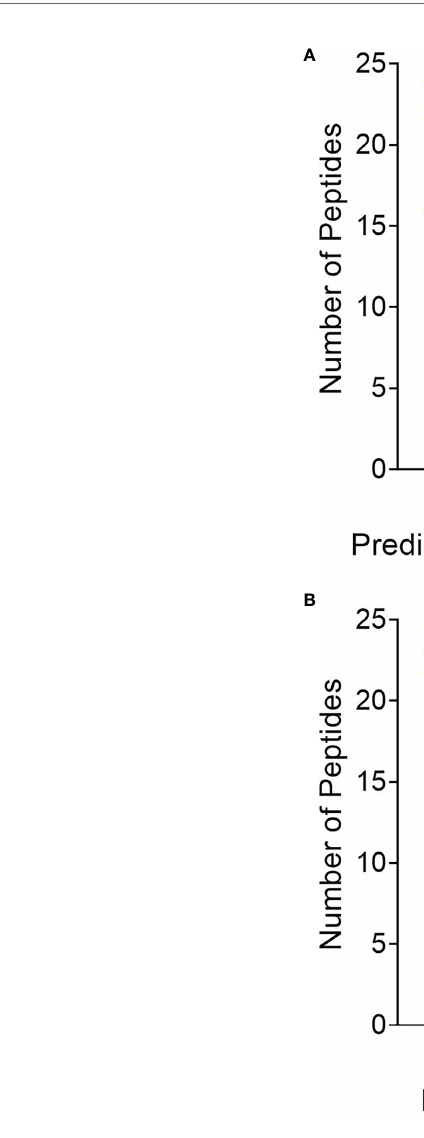
FIGURE 4 | Comparison of predicted (A) to in vitro (B) HLA-DR allele binding for the 46 peptides representing 40 in silico predicted class II epitope clusters shows an increase from the prediction in the number of peptides that bind all eight HLA-DR alleles in vitro